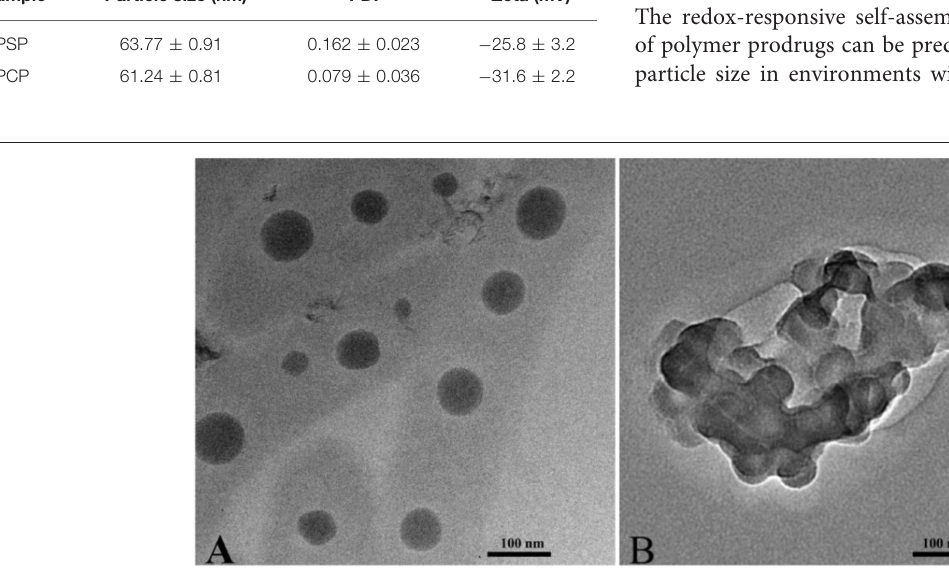
FIGURE 3 | TEM images of micelles formed by PPCP (A) and PPSP (B) .